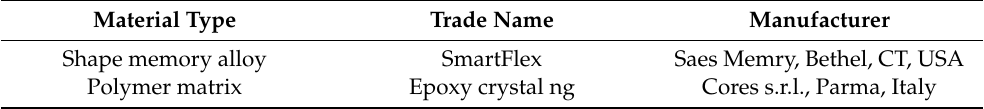
Table 1. Selected SMA and polymer materials for smart